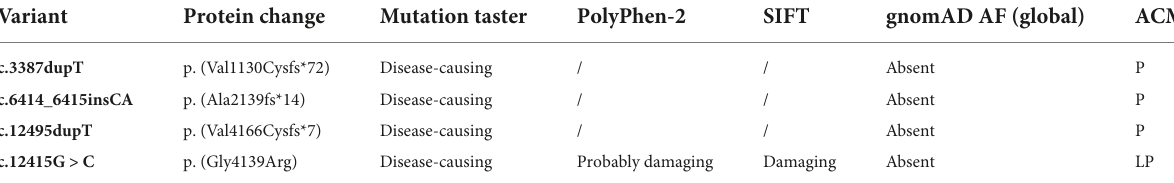
TABLE 2 Pathogenicity of USH2A novel variants found in our cohort.